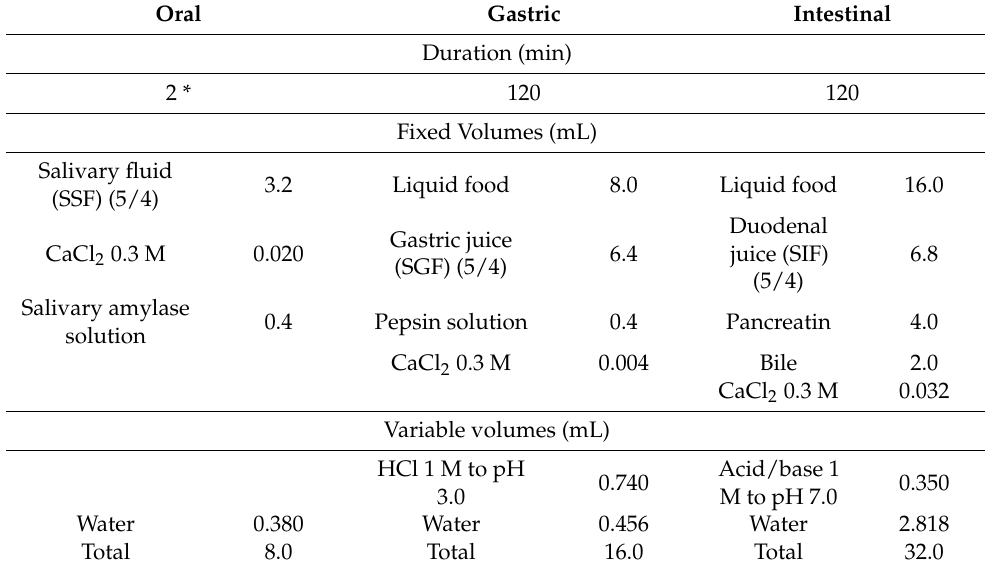
Table 1. Simulated sequential steps of gastrointestinal digestion assay based on modified INFOGEST protocol (semi-dynamic